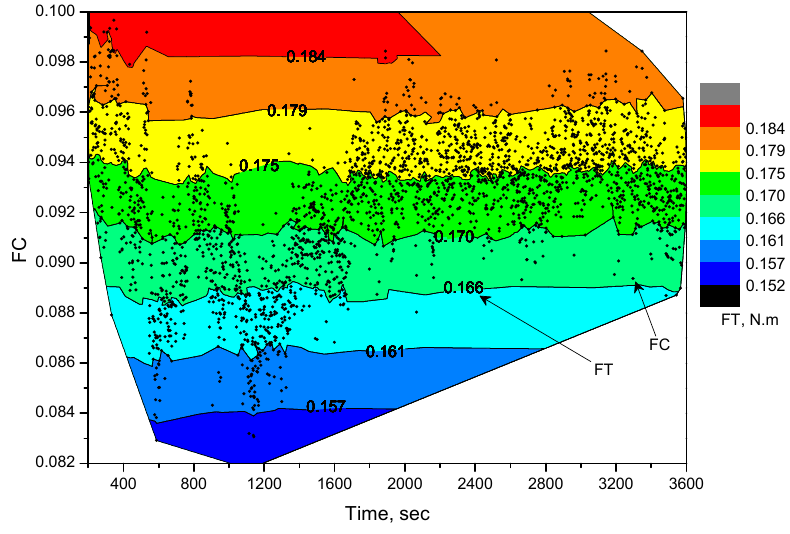
Figure 5. Correlation of FT and FC at steady state conditions for ManCr_Pa mixture blend.